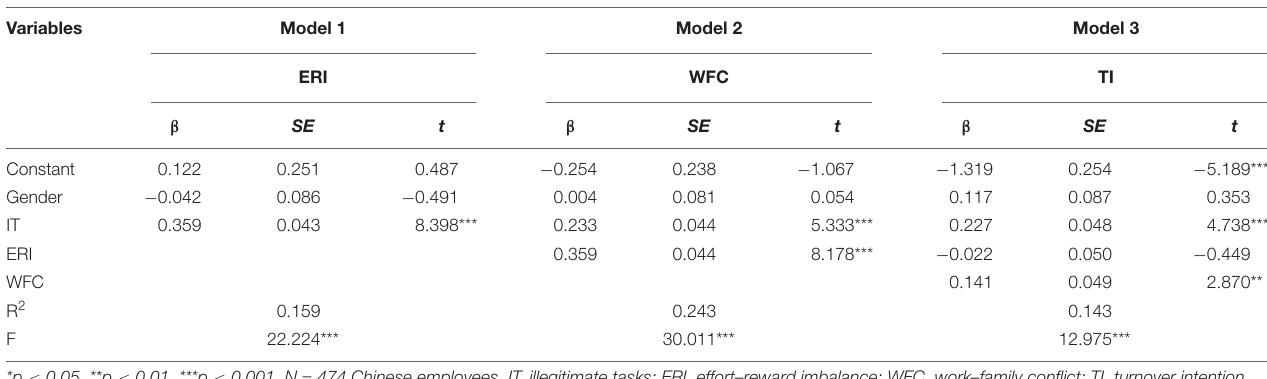
TABLE 3 | Model results.